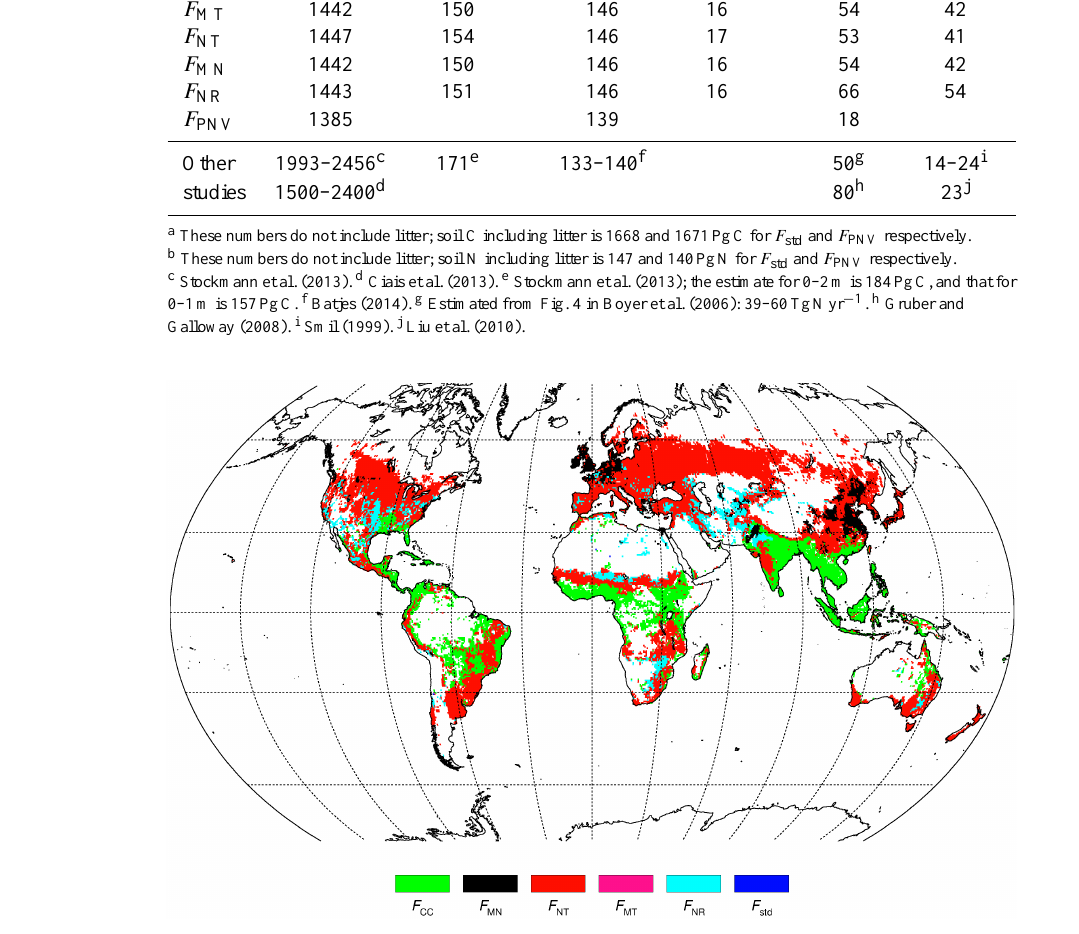
Figure 4. Optimal carbon sequestration practice ( F opt ) around the year 2000, as simulated by LPJ-GUESS, based on the different manage- ment practices and trade-offs shown in Fig. 3 (see also Table 2 for the abbreviations). The standard set-up ( F std , blue) was selected when none of the other management types gave an increase in the amount of carbon sequestered. The C sequestered compared to F std for choosing the optimal practice in each grid cell is 7.7PgC from 1750 to 2000; the reduction in global N leaching for best C sequestration practices is 11.9TgNyr − 1